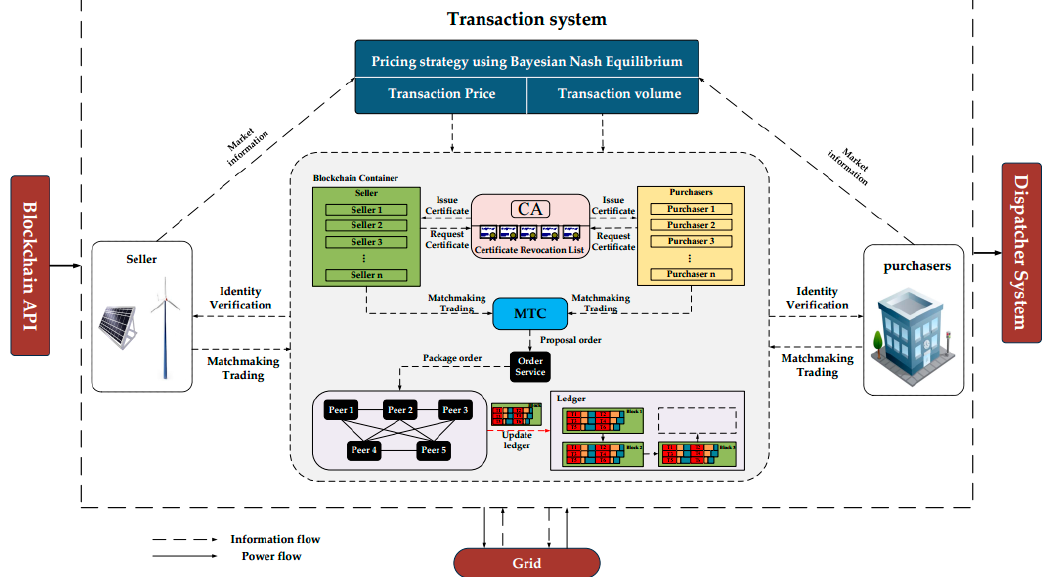
Figure 2. Overall structure of the microgrid market trading model.